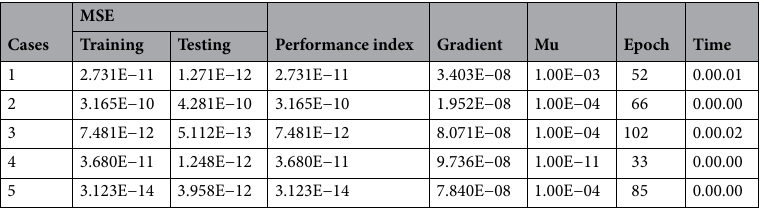
Table 4. Scenario 2: variation of A 2 .